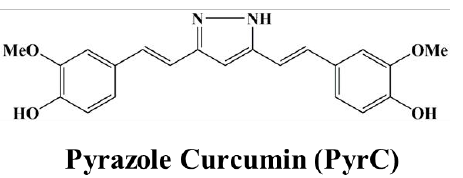
Figure 1. The chemical structure of curcumin and its analogs.